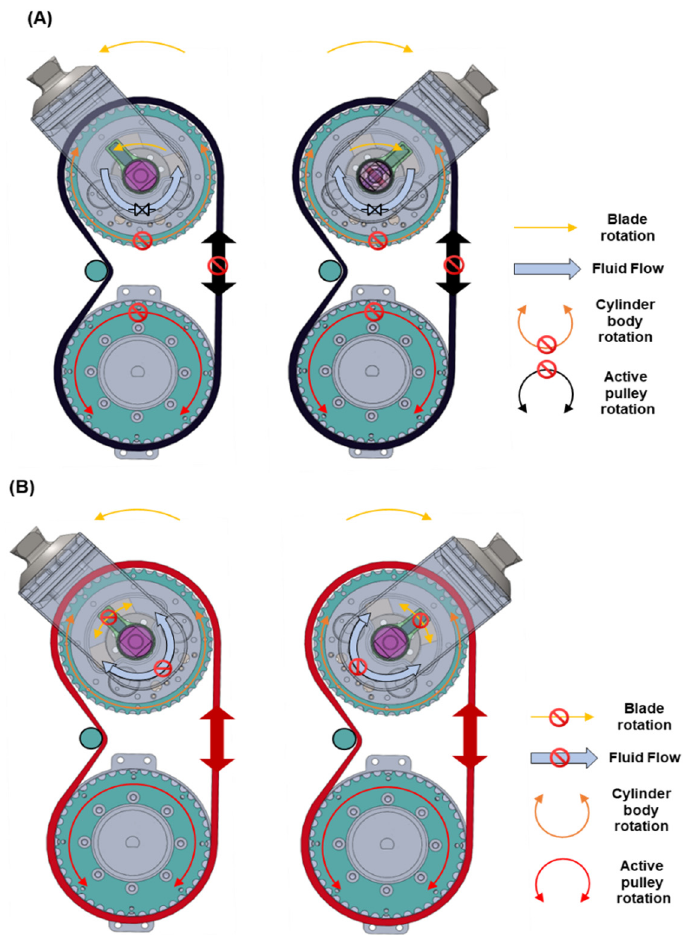
Figure 1. Driving rotary hydraulic cylinder and active motor module according to passive/active mode: ( A ) bi-directional rotation of the rotary blade in passive mode, ( B ) bi-directional rotation of cylinder body in active mode.